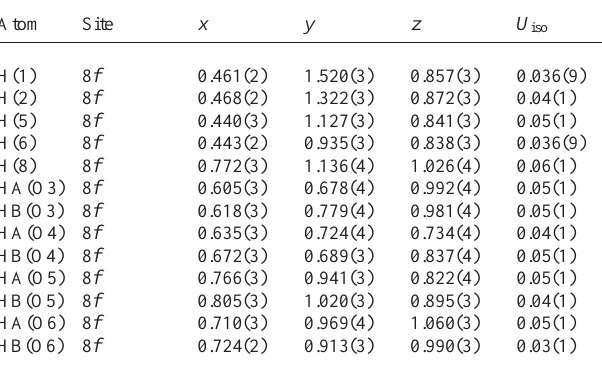
Table 2. Atomic coordinates and displacement parameters (in Å 2 )